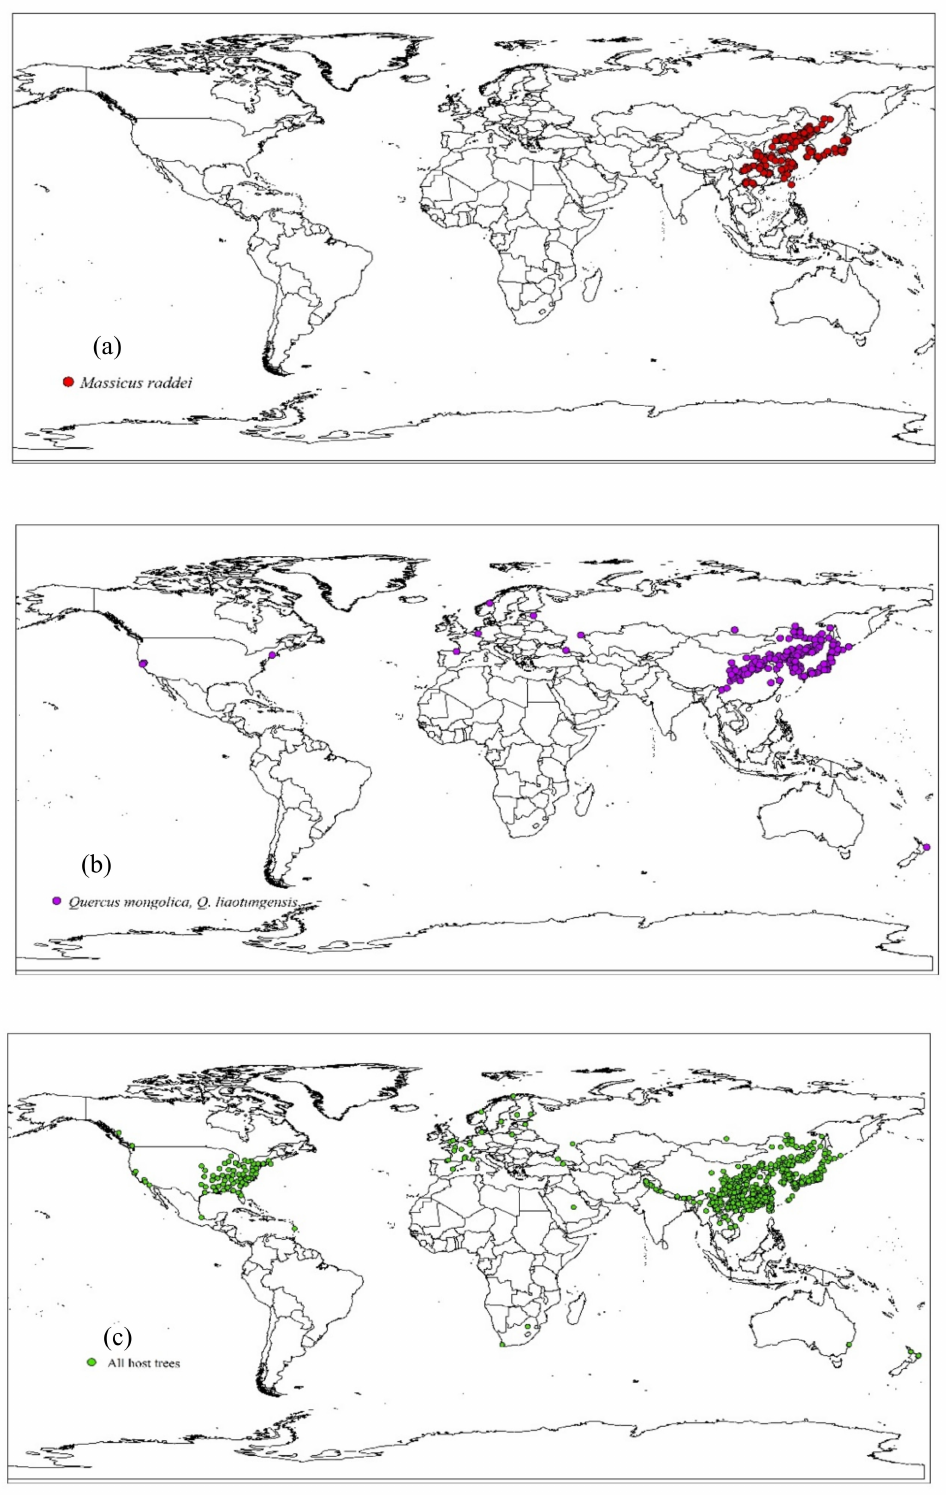
Figure 1. Global actual distributions of M. raddei ( a ), two susceptible hosts ( Q. mongolica and Q. liao- tungensis ) ( b ) and all host trees ( c